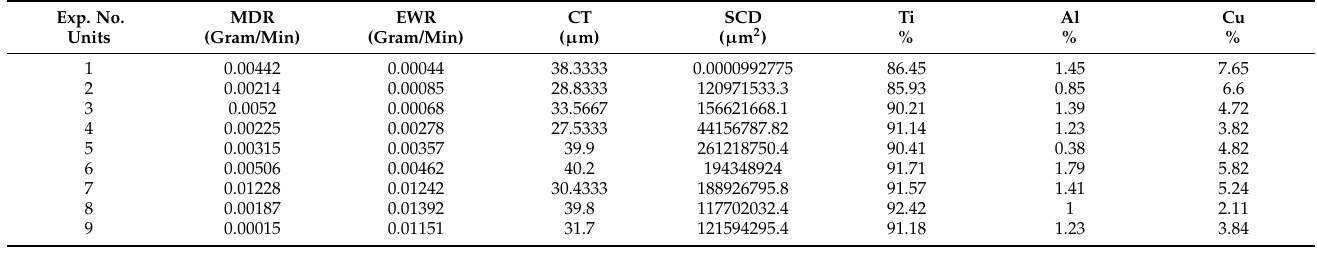
Table 6. Output response parameters.